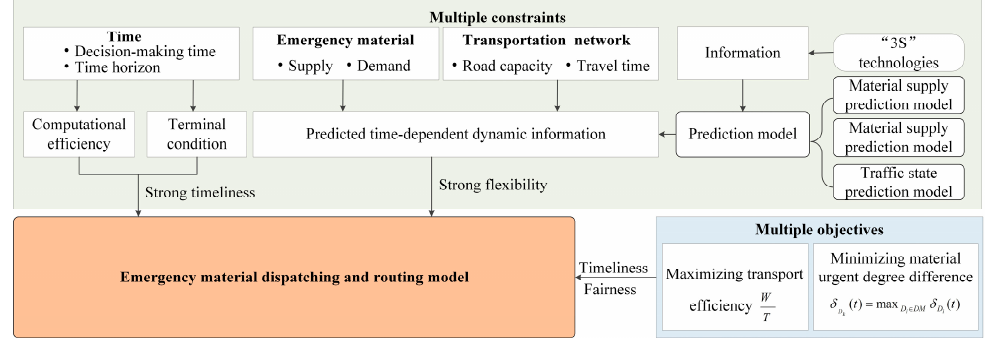
Figure 2. Single VS multiple objectives of vehicle dispatching: ( a ) single-objective; ( b ) multiple objectives.